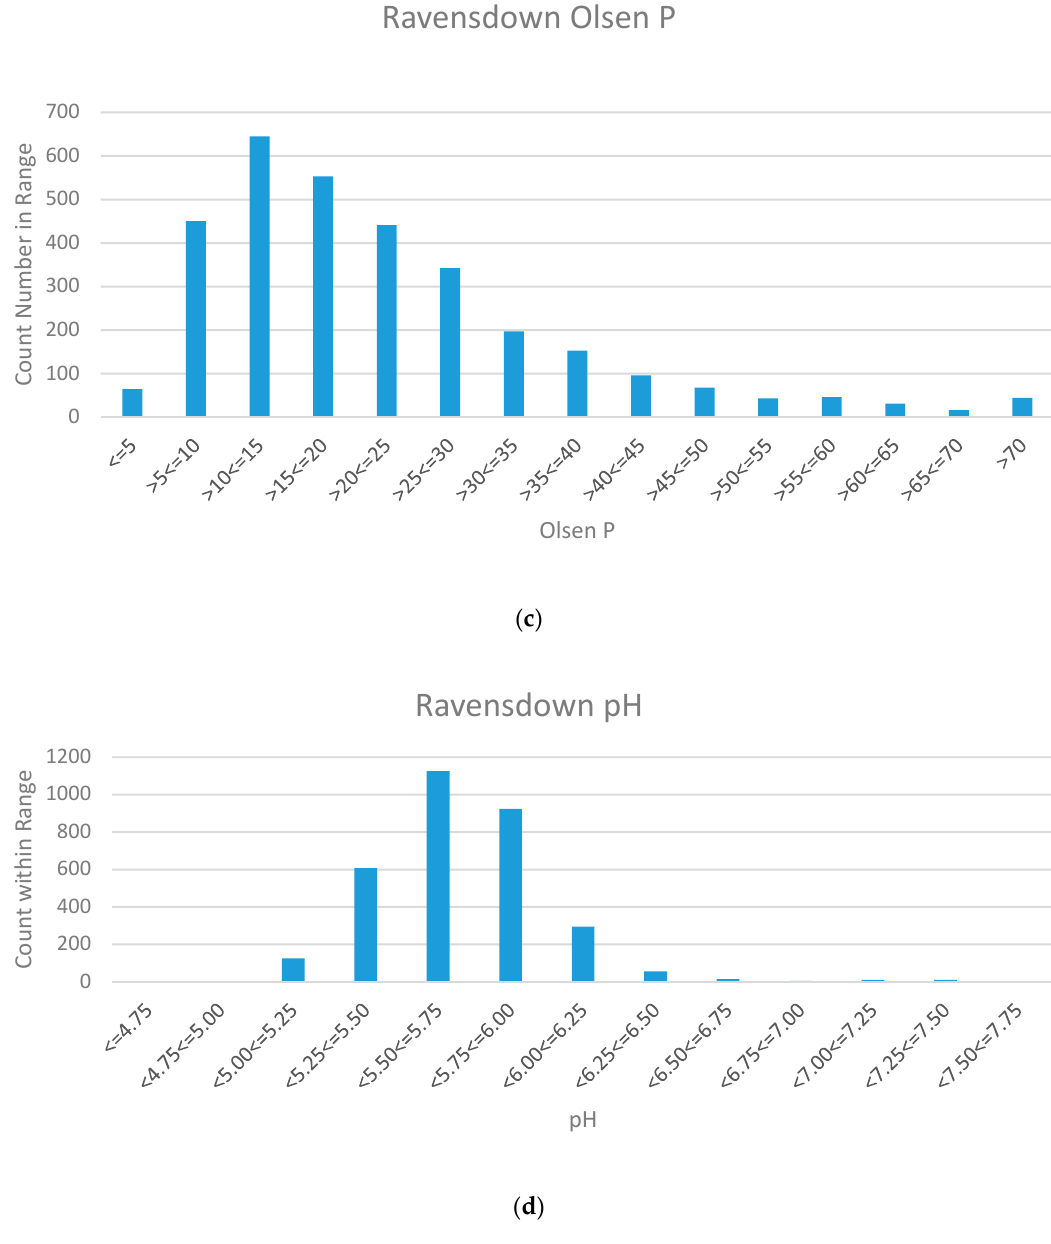
Figure 3. ( a ) Shows the distribution of the Massey Olsen P data; ( b ) shows the distribution of Massey pH data; ( c ) shows the distribution of Ravensdown Olsen P data; and ( d ) shows the distribution of Ravensdown pH data.